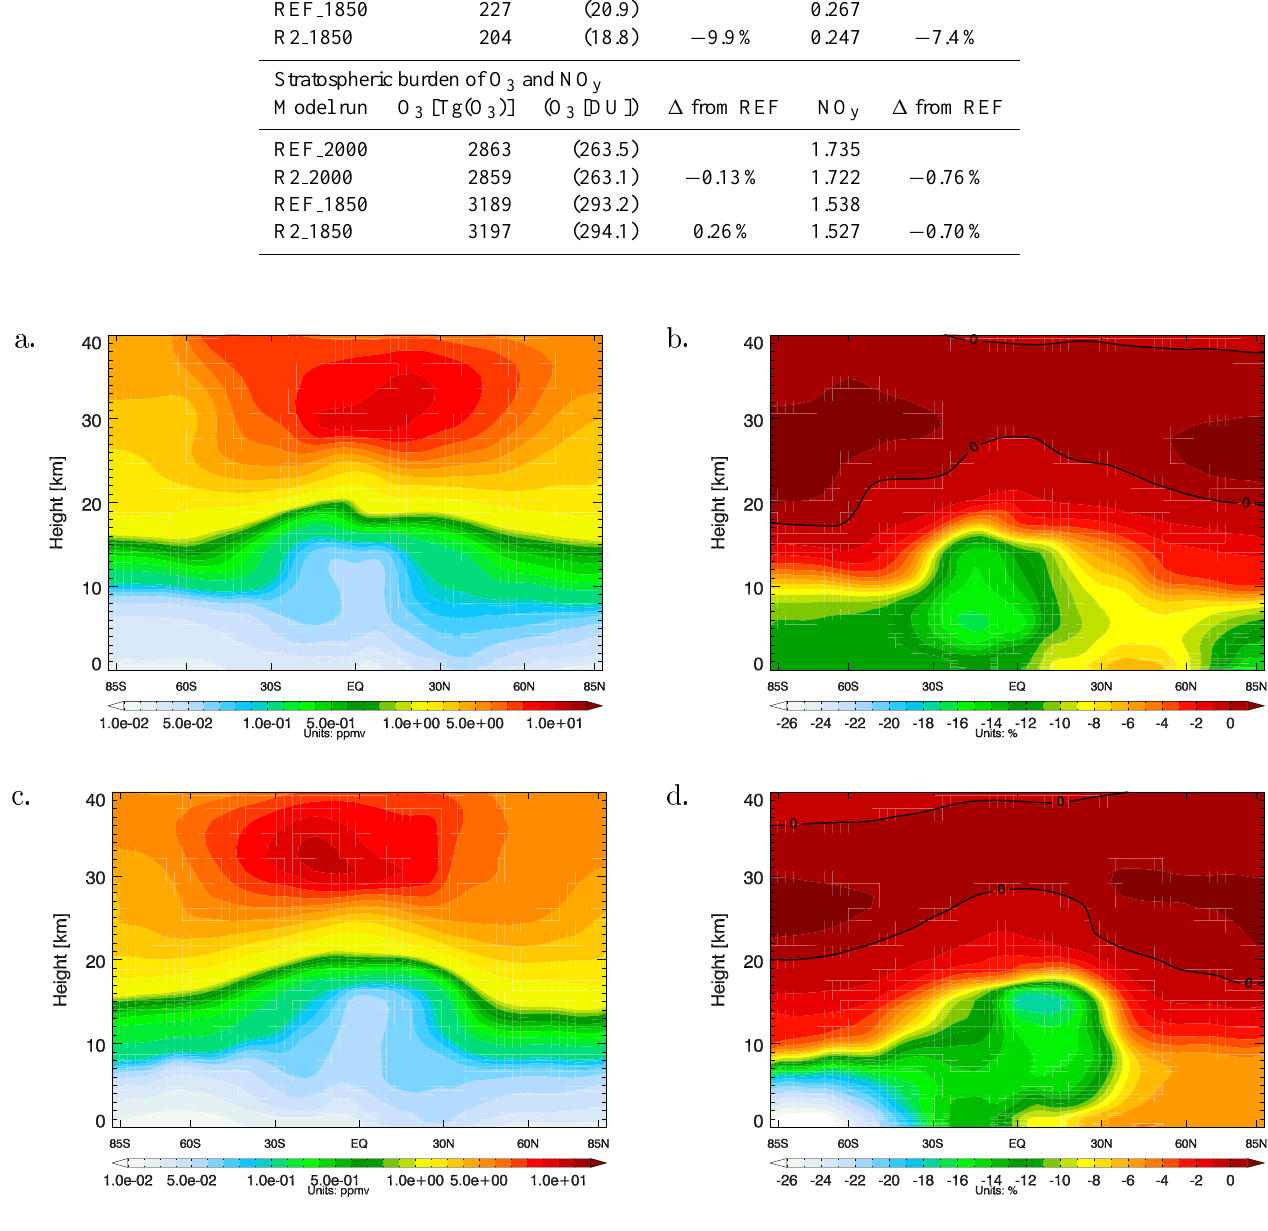
Fig. 4. The zonal mean O 3 mixing ratio in REF 2000, for July (a) and December (c) . Panels (b) and (d) show the percent change in mixing ratio from REF 2000 to R2 2000, for July and December,